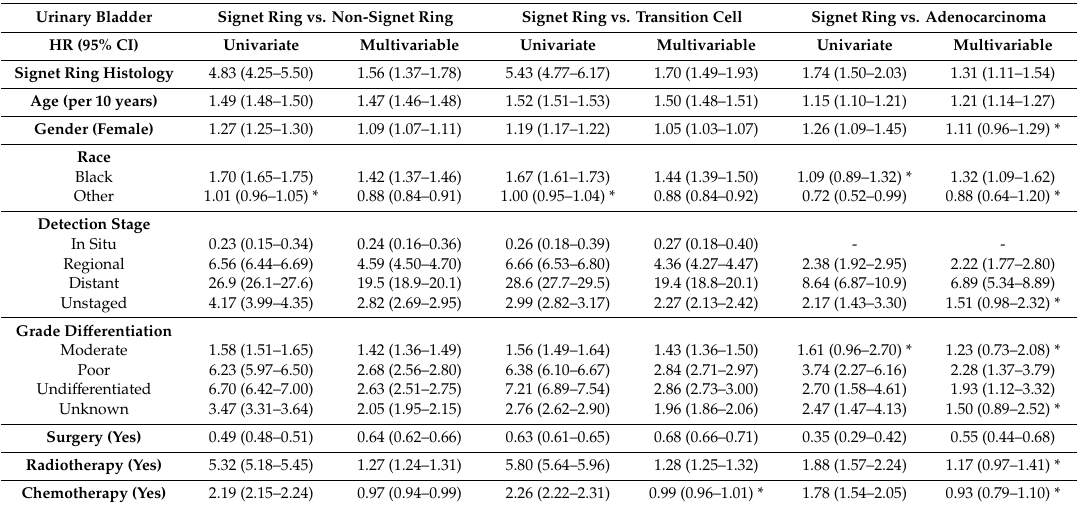
Table 20. Derived univariate and multivariable Cox-proportional hazard ratios (HR) of mortality for urinary bladder